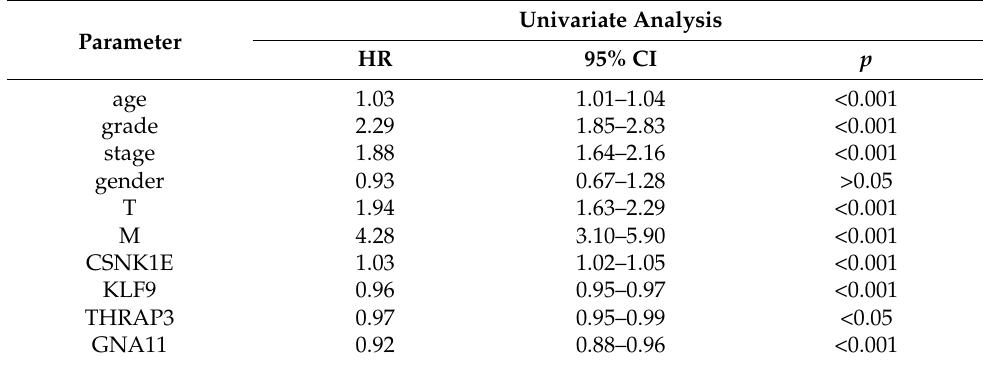
Table 1. Univariate cox analyses of the correlation of CSNK1E/GNA11/KLF9/THRAP3 expression with OS among KIRC patients.